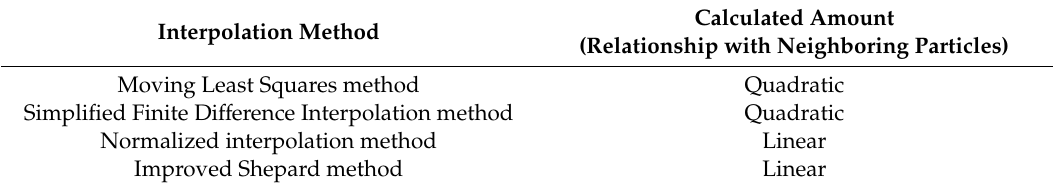
Table 1. Comparisons of calculated